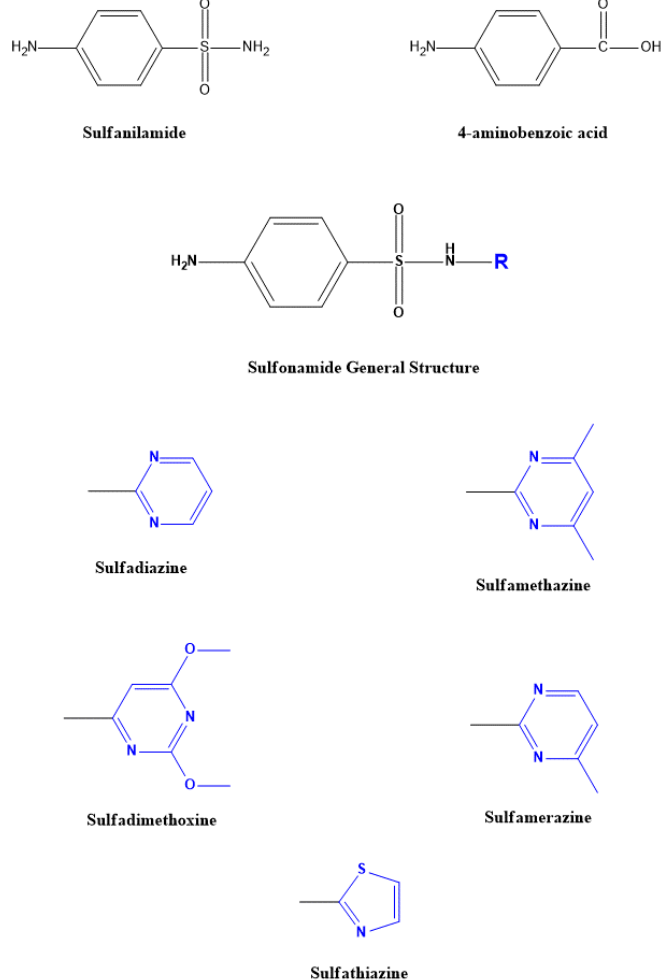
Figure 1. Diagrams of the chemical structure of sulfonamide, sulfanilamide, 4-aminobenzoic acid, and the chemical structure of the most common SA analogues in veterinary medicine.